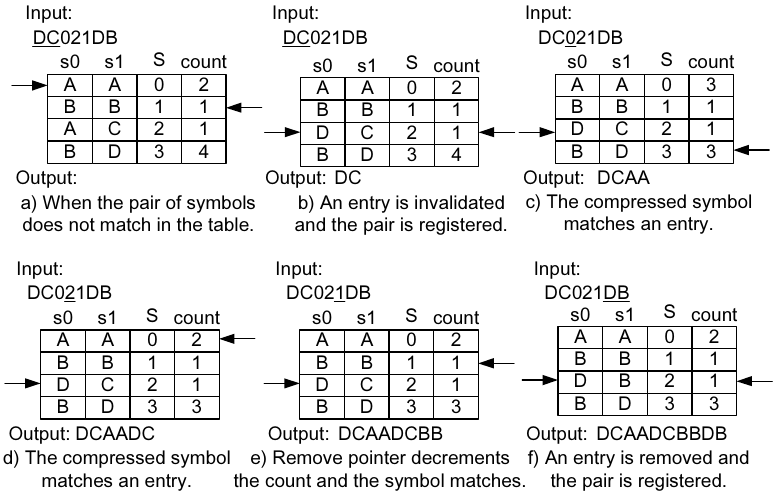
Figure 7. Example of a decompression mechanism using the dynamic